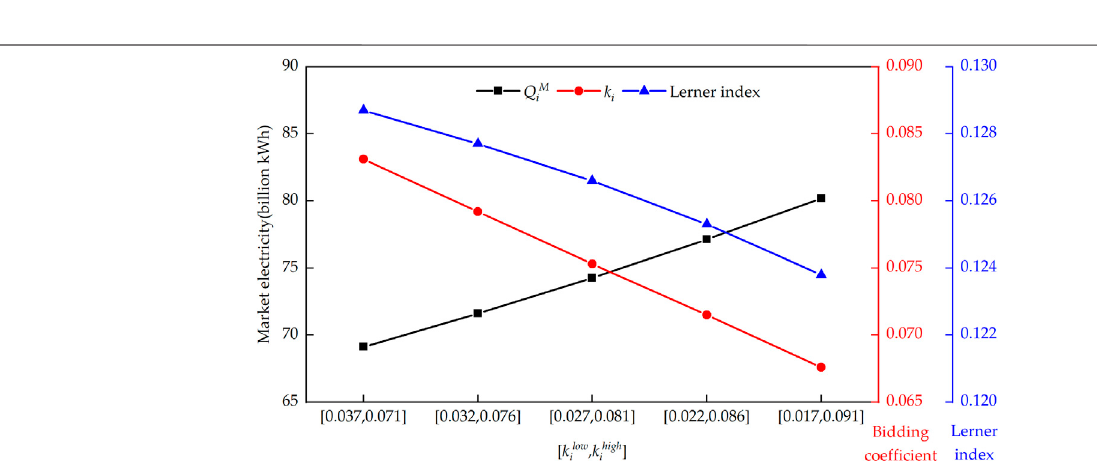
FIGURE 7 | The relationship between the bidding strategy of generation company WN and the uncertainty of rival bidding.